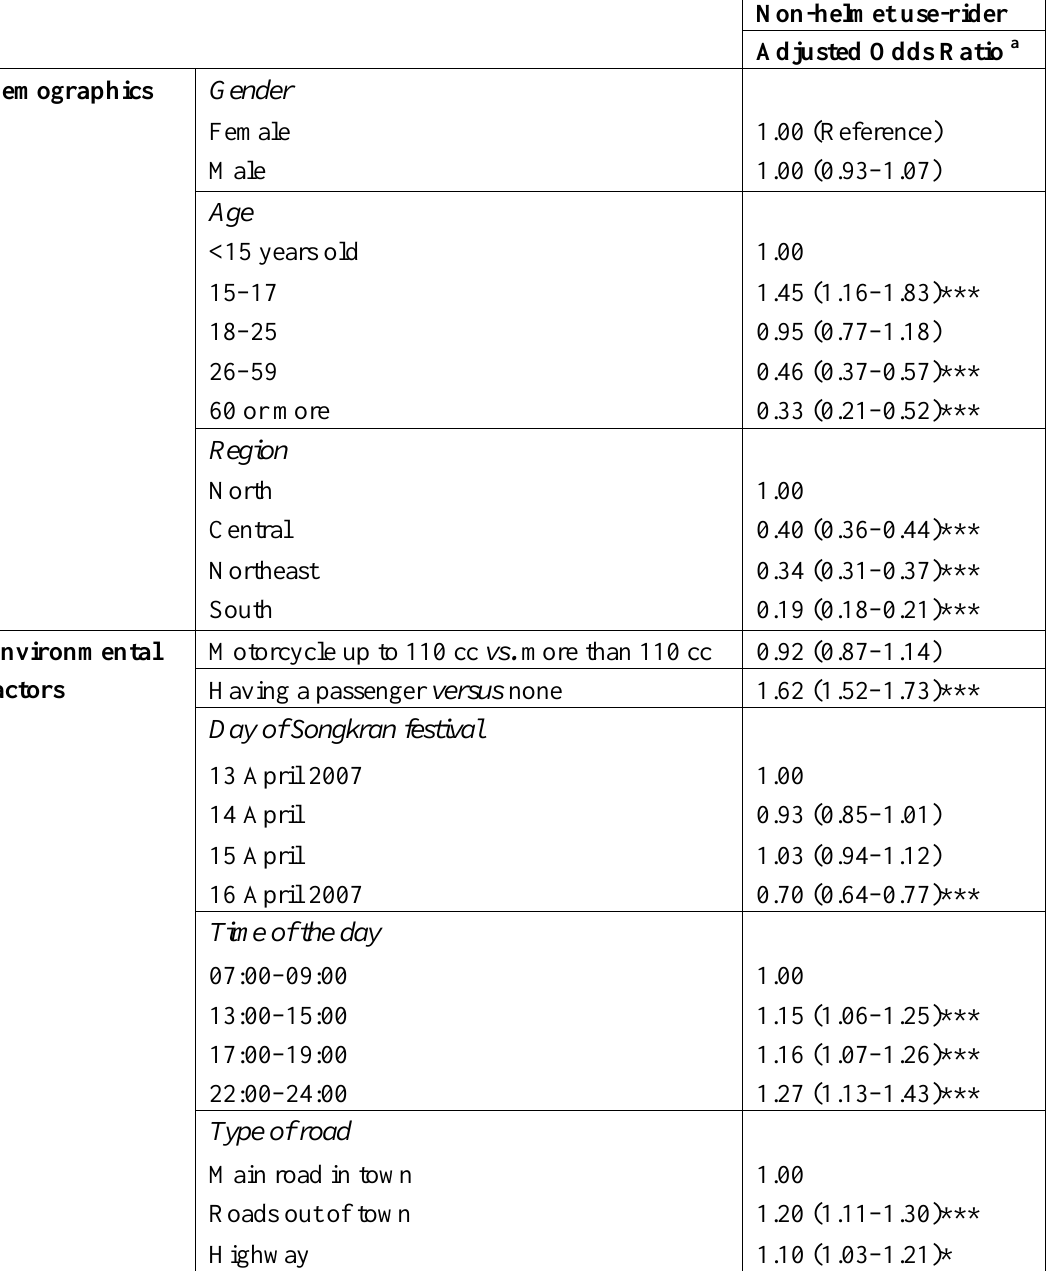
Table 3. Results: Association between non-helmet use and demographics, environmental factors, helmet use experiences and attitudes and RSA campaign exposure (during Songkran festival) by the logistic